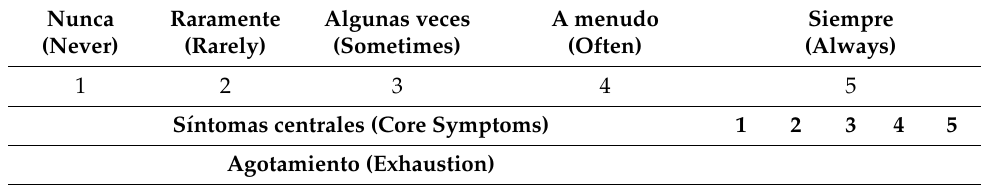
Algunas veces (Sometimes)